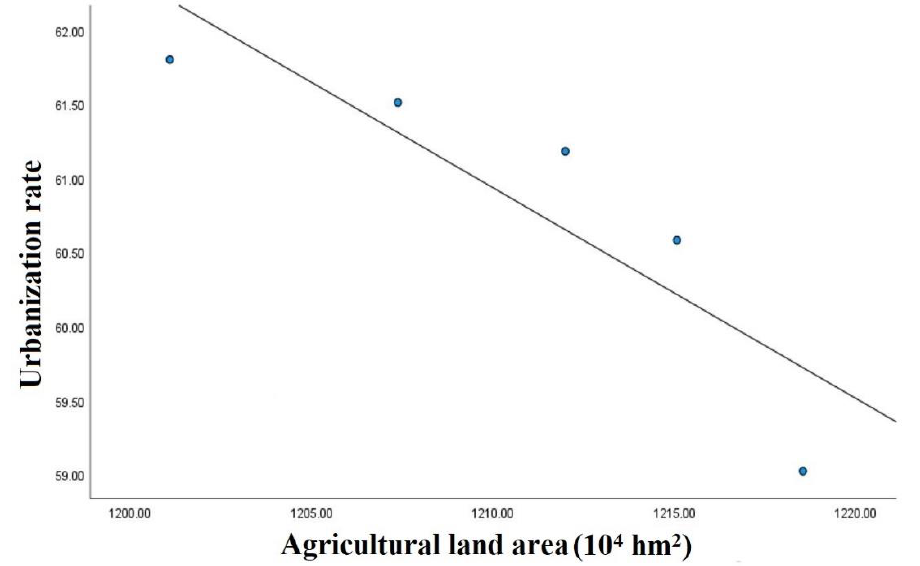
Figure 13. Correlation analysis of agricultural land area and urbanization